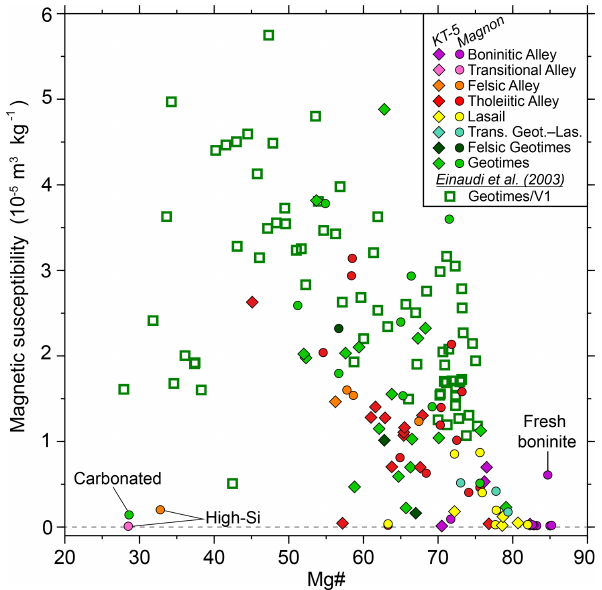
Figure 8. Magnetic susceptibility vs. whole rock Mg# (molar Mg /( Mg + Fe total ) × 100) for the four main Semail volcanic units. Circles and diamonds: this study. Squares: Geotimes/V1 sam- ples from Einaudi et al. (2003). Outlying analyses: fresh boni- nite TB3-01A; highly carbonated Geotimes TB3-20I (Loss on igni- tion = 16wt%) from vicinity of late carbonate vein; high-Si Transi- tional Alley TB3-15C (70wt% SiO 2 ) and Tholeiitic Alley TB2-34 (84wt% SiO 2